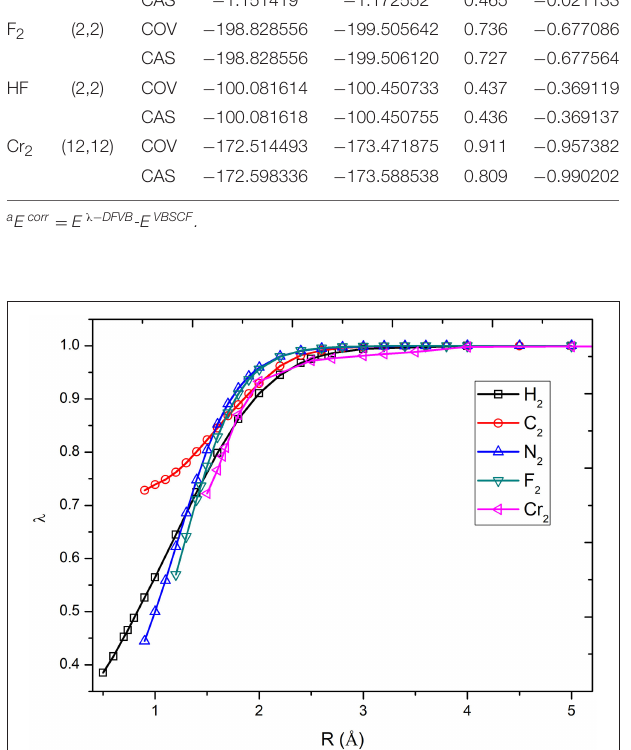
Table 1 displays the VBSCF and λ -DFVB energies of H 2 , F 2 , HF, N 2 , C 2 , and Cr 2 with the CAS and COV levels of the VB wave function. The number of active electrons and active orbitals ( n e , n o ) are listed in the second column. The dynamic correlation correction of λ -DFVB, which is defined as the energy difference between VBSCF and λ -DFVB, is listed in the last column. The corresponding data for polyatomic molecules CH 3 -CH 3 , C 2 H 4 , and C 2 H 2 are shown in Table S3 . In general, the λ values of CAS are smaller than those of COV. The molecules with strong correlation tend to have the large λ values. Among them, H 2 has the smallest dynamic correlation correction while Cr 2 has the largest one. The λ -DFVB calculations in the next are carried out at the CAS level of the VB wave